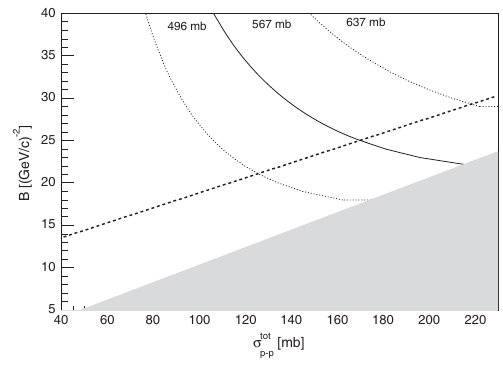
FIG. 7 (color online). The proton-air cross section result of this work, including the statistical (outer/thinner) and systematic (inner/thicker) error bar. The result of this work is shown in comparison to other experimental results [1,2,28 – 34]. In addi- Figure 3. X max distribution measured by TA. The line shows tion, the high-energy models (QGSJETII.4, QGSJET01, the result of exponential fit in the range between 790g / cm 2 and SIBYLL, EPOS-LHC) cross section predictions are also shown 1000g / cm 2 (Figure from [5].) by solid line, fine dashed line, dotted line, and dashed line consecutively.